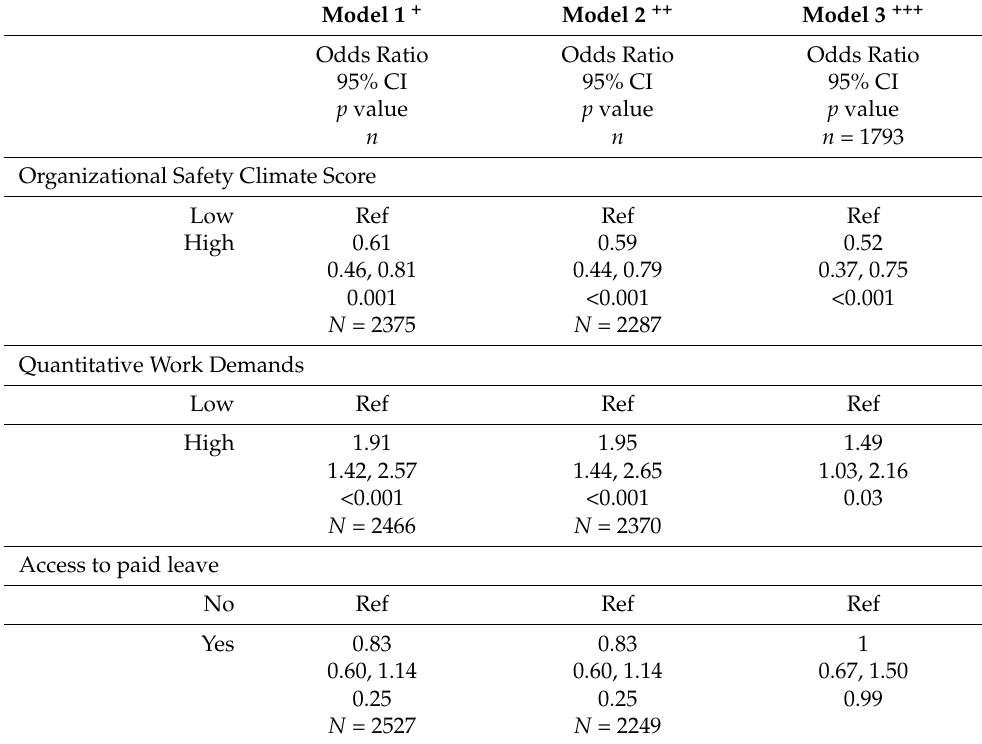
Table 3. Workplace and non-workplace factors associated with reporting presenteeism intentions in a national food chain worker sample during early